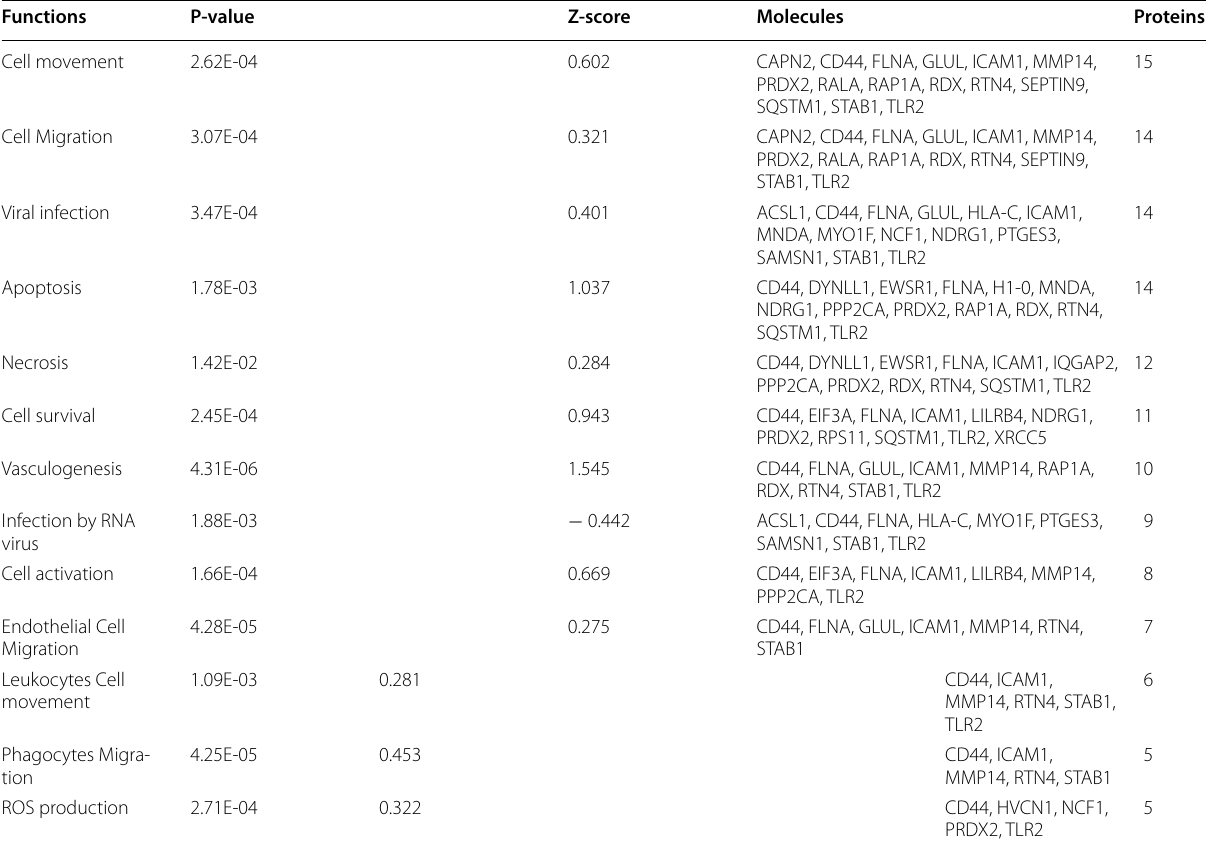
Table 2 Functional classification of differentially expressed proteins in CACs after PCR